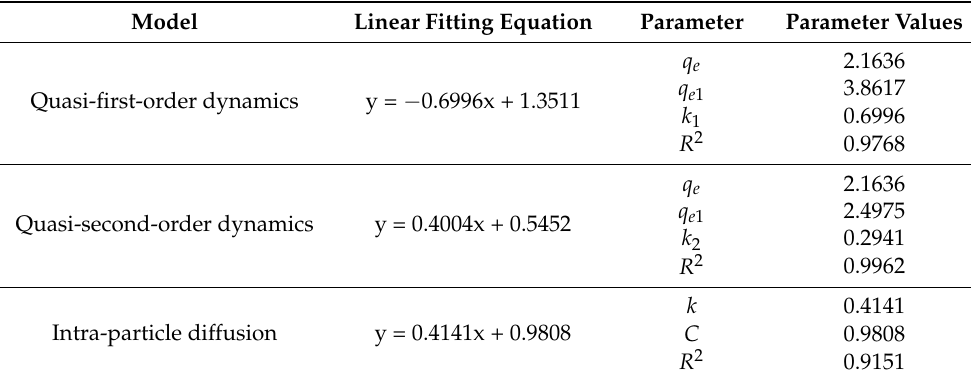
Table 2. Calculation results of adsorption kinetic equation